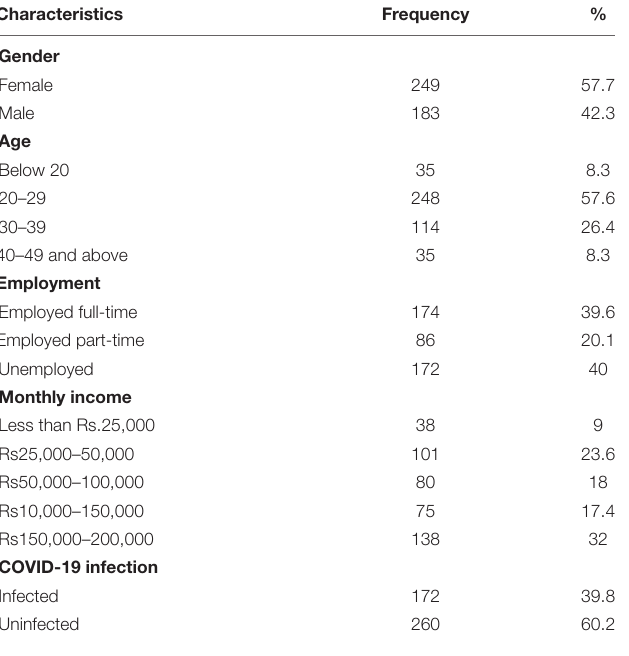
TABLE 1 | Demographic